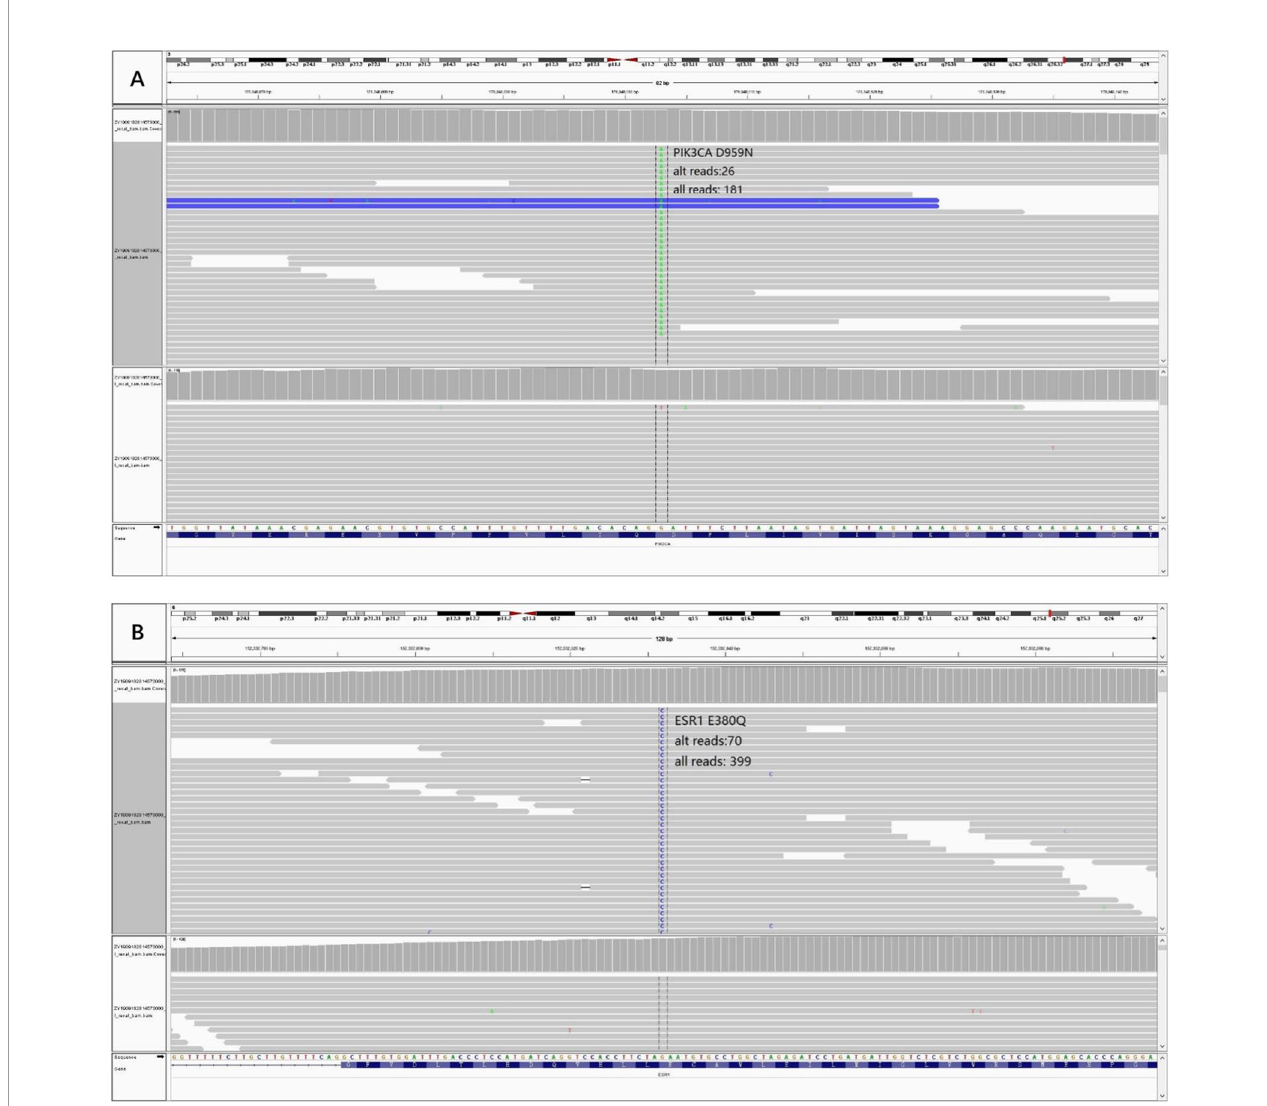
FIGURE 4 | Acquired mutations were detected in the sample of peritoneal metastatic lesion and visualized through Integrative Genomics Viewer (IGV). (A) Variant PIK3CA p.D959N IGV plot (all reads: 181, alternative allele supported reads: 26). (B) Variant ESR1 p.E380Q IGV plot (all reads: 399, alternative allele supported reads: